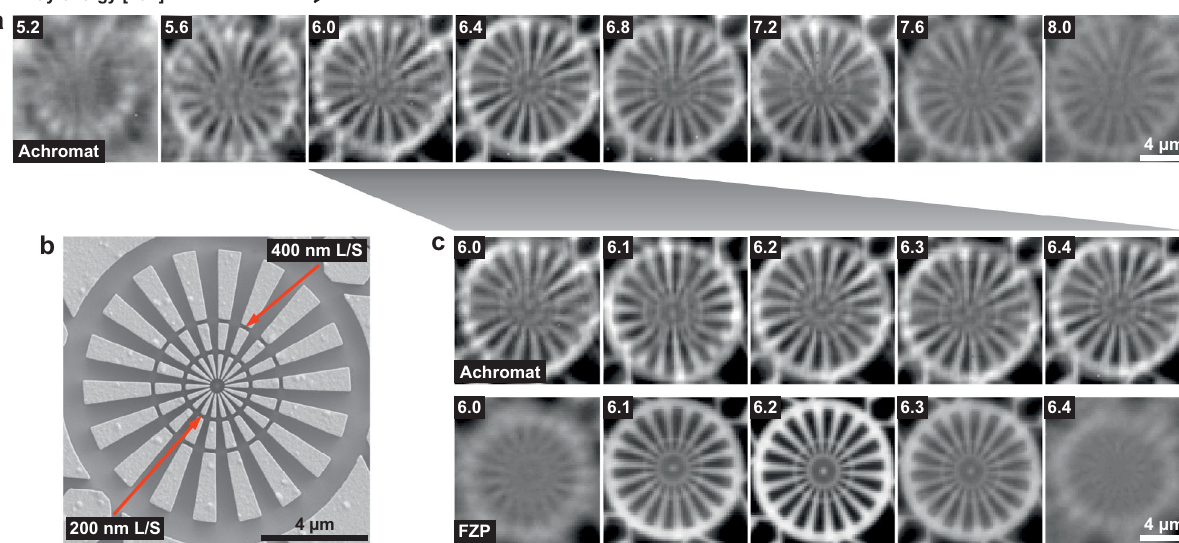
Fig. 2 Demonstration of STXM imaging at different energies using the achromat. a STXM images of the Siemens star sample shown in panel b obtained with the achromat, indicating an achromatic range of > 1 keV around the optimum energy of ~ 6.4 keV. b SEM image of the Siemens star test sample. The radial lines and spaces (L/S) at the outer and inner concentric rings have widths of 400nm and 200 nm, respectively, see red arrows. c Comparison of the STXM results in the energy range of 6.0 keV to 6.4 keV obtained with the achromat (top) and the conventional FZP (bottom). While the contrast of the FZP images changes rapidly with the energy, the image quality achieved with the achromat varies only Fig. 1d, through the caustics of the achromat are shown in Fig. 3a, where the focus position is indicated with a red dashed line. A direct comparison of the caustics obtained with the achromat and the FZP, see Fig. 3b, con fi rms the signi fi cant gain in achromatic range achieved by the achromat, as already observed in the STXM images in Fig. 2. The experimental results for the location of the focal spot agree well with the corresponding calculated curves for both the achromat and the FZP, see Fig. 3c. The difference between the solid and dashed red curves for the achromat, which were cal- culated using Eq. (6) and inserting tabulated δ and β values 15 into Eq. (4), respectively, is small. This indicates that the assumption of no material dispersion that was made in Eq. (6) holds well, see